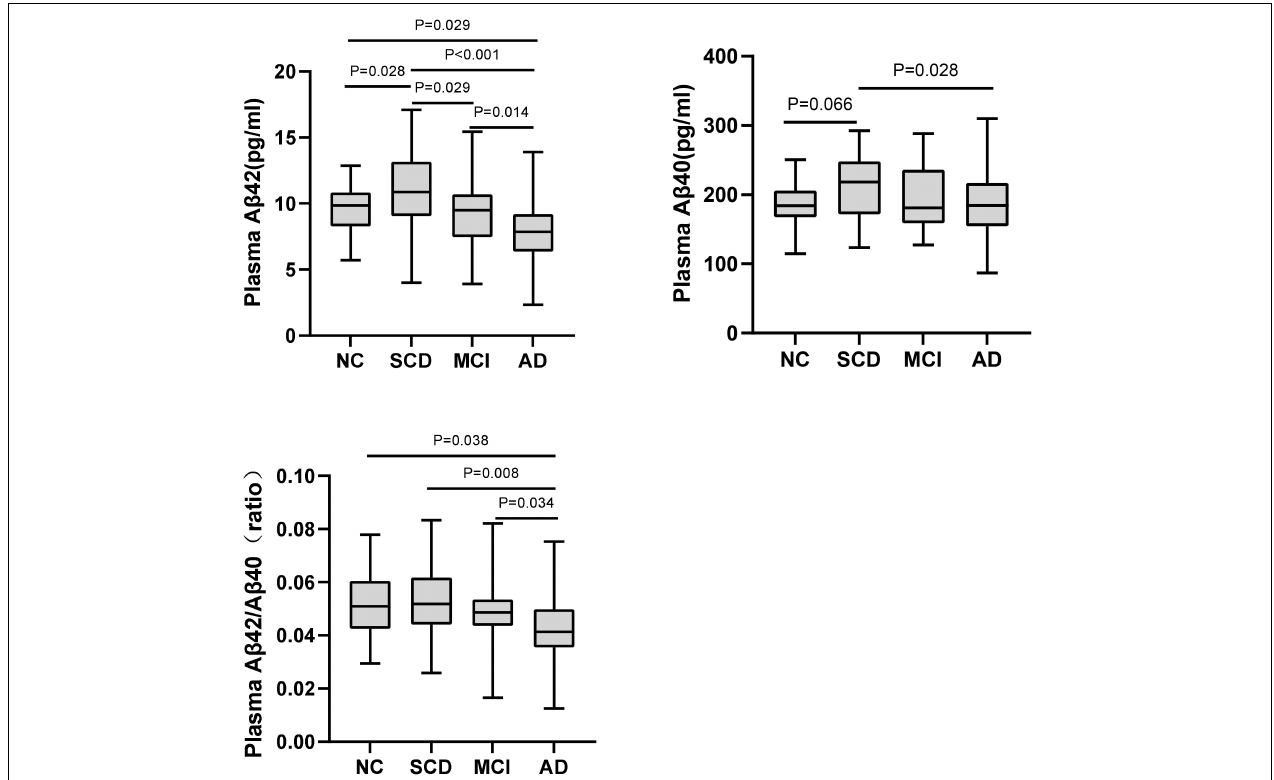
FIGURE 2 | Pairwise comparisons of plasma A β 42, A β 40, and A β 42/A β 40 among NC, SCD, MCI, and AD dementia with A β -PET (+). P -values were adjusted for age, sex, and education